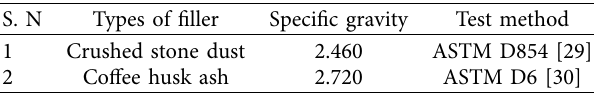
Table 4: Physical properties of CSD and